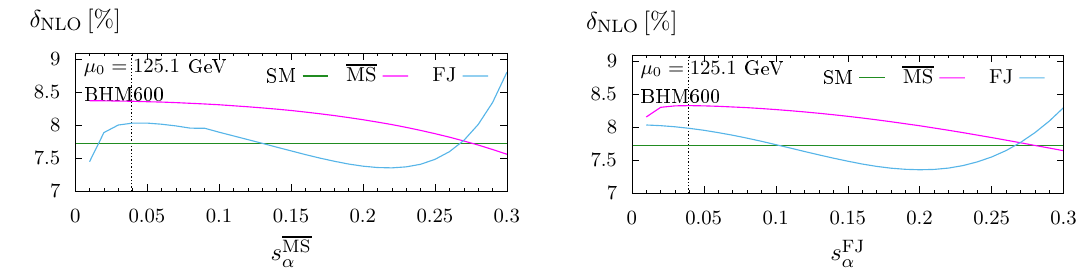
Figure 19 . s (cid:11) dependence of the relative EW+QCD NLO corrections to the decay width (cid:0) h ! 4 f . Free parameters other than s (cid:11) are (cid:12)xed according to benchmark scenario BHM600 (see table 2). The vertical dashed line signals that for s (cid:11) . 0 : 04 perturbativity problems might arise.